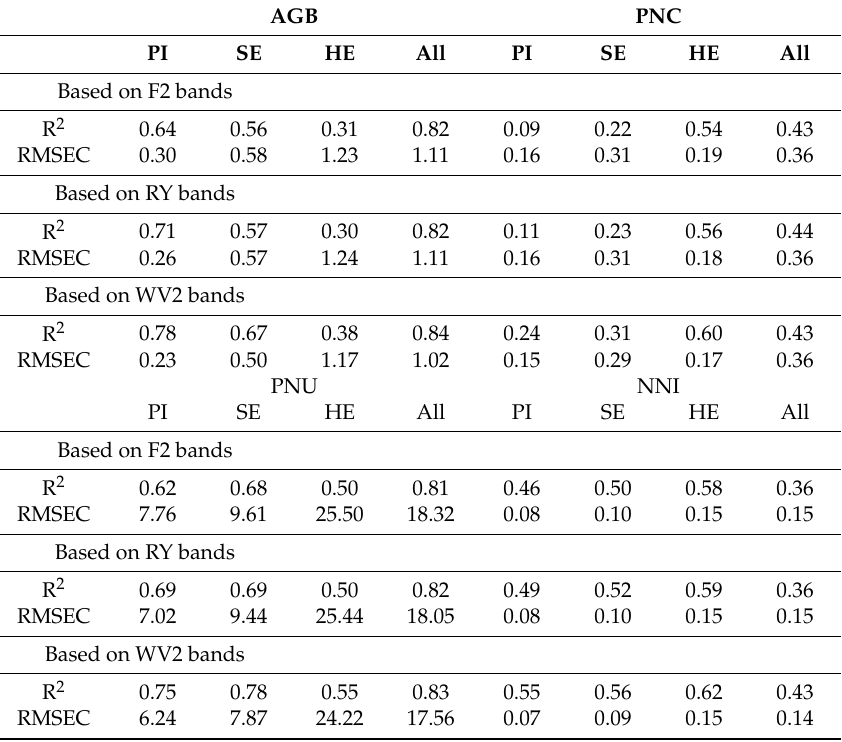
Table 8. Aboveground biomass (AGB), plant N concentration (PNC), plant N uptake (PNU),